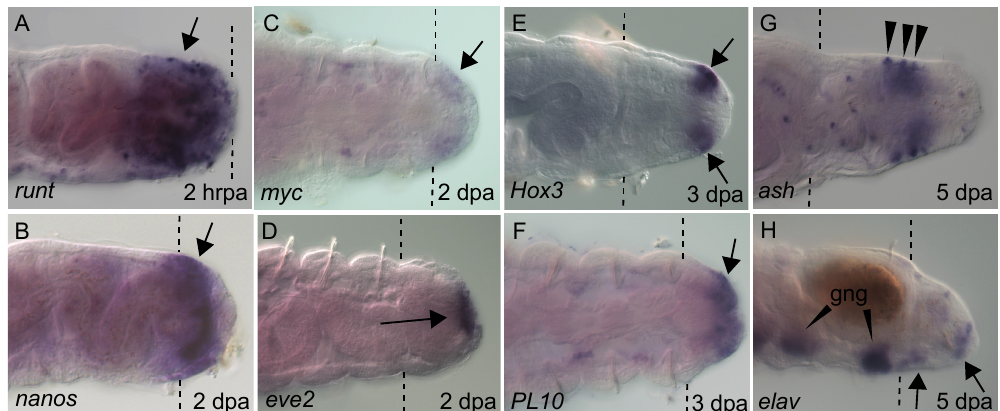
Figure 4. Gene expression in regenerating tissue. Whole mount in situ hybridization showing gene expression of developmental regulatory genes at different stages of regeneration. All panels show the posterior end of regenerating animals, with anterior to the left. Purple precipitate indicates mRNA (arrows). Gene name is indicated in bottom left of each panel. Time after amputation is indicated in the bottom right of panel in either hours (hrpa) or days post amputation (dpa). Panels ( B – G ) are in ventral view and ( A , H ) are in lateral view. ( G ) Punctate expression is ash expression associated with the enteric nervous system. ( H ) Ganglia expressing elav in pre-existing tissue are indicated (gng). Brown ellipse in panel H is a fecal pellet. Dotted lines indicate amputation site. Hox3 expression was previously published [19].